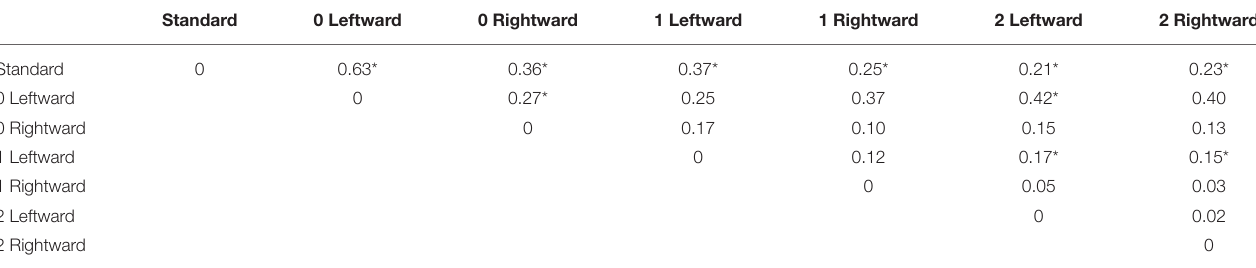
FIGURE 2 | Auditory LD accuracy by Hierarchy category for L1 ( n = 38) and L2 ( n = 31) English listeners. “X” marks the sample mean and center lines the median of listeners’ individual mean LD accuracy, box limits indicate the interquartile range, whiskers contain all sample values within 1.5 times the interquartile range, and outliers are represented by dots.